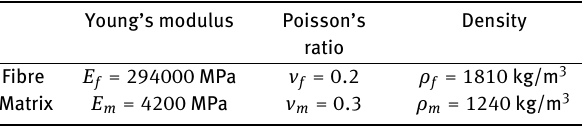
Table 1: Material properties of fibre and polymer matrix.